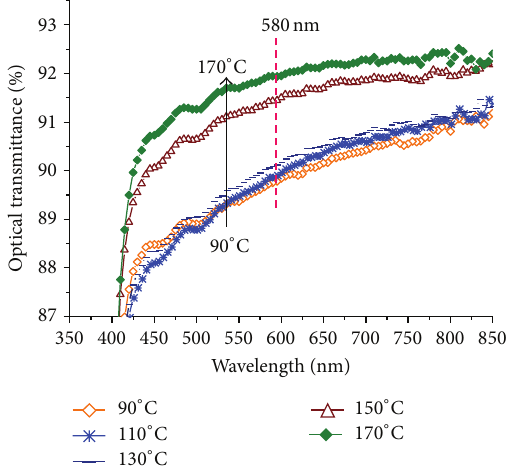
Figure 5: Transmittance as a function of lamination temperature at the lamination time of 7 minutes.